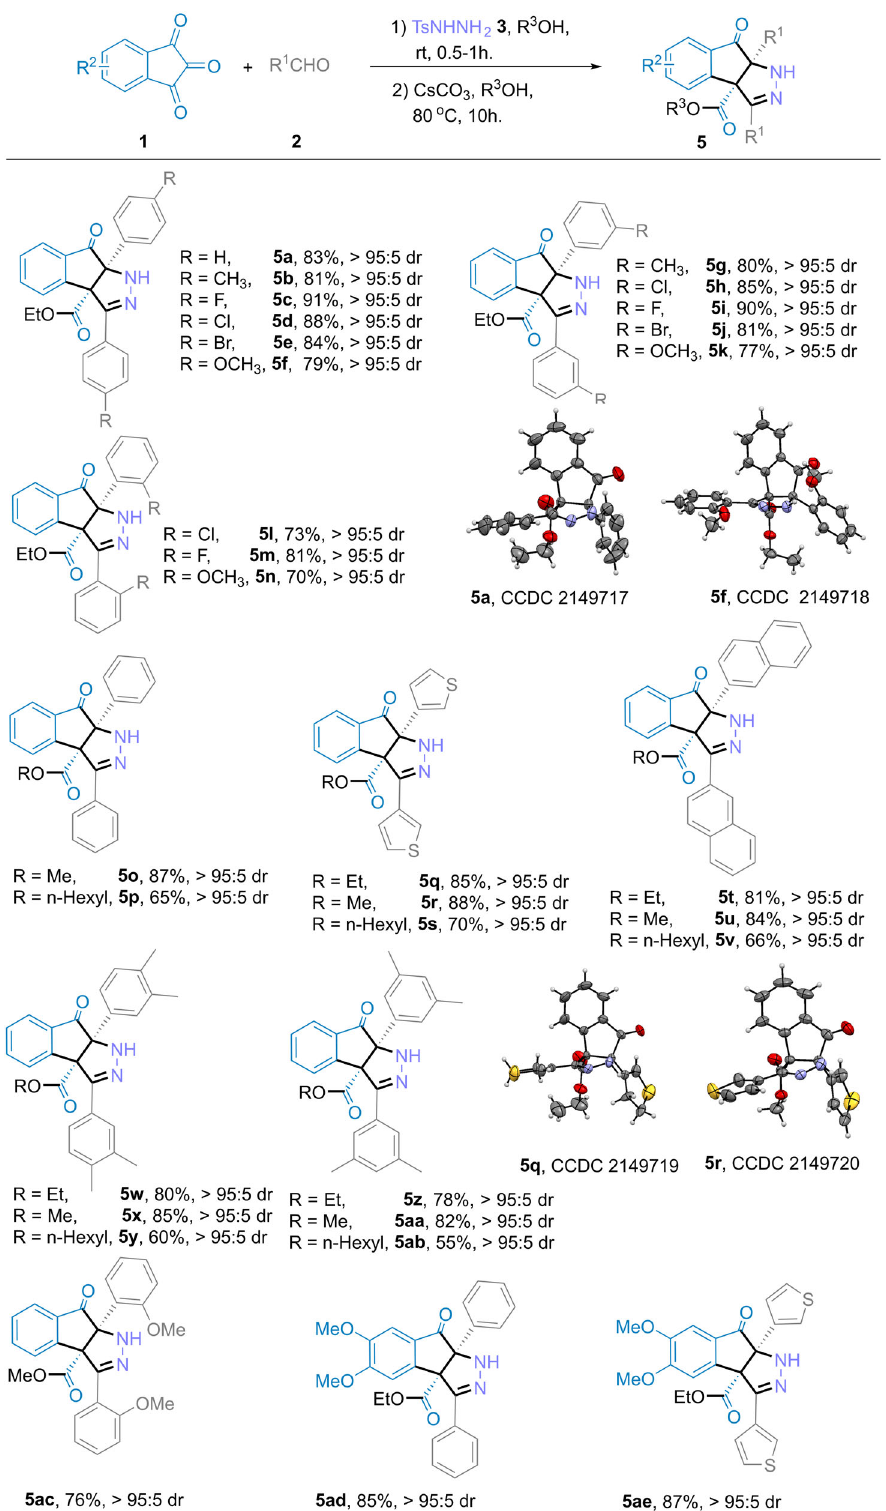
Fig. 4 Substrate scope of indantriones and aldehydes for producing indenopyrazoles. a General conditions: (1) In a 25 mL reaction tube, aldehyde 2 (2.1 mmol), p -toluenesulfonyl hydrazide 3 (2.1 mmol), R ’ OH solvent (20 mL), under ambient atmosphere (1 atm), stirred for 0.5 – 1 h. (2) indantrione 1a (1.0 mmol), Cs 2 CO 3 (3.0 mmol), at 80 °C for 10 h. b The dr value was determined by 1 H-NMR analysis of crude products. c Isolated yield based on 1a .